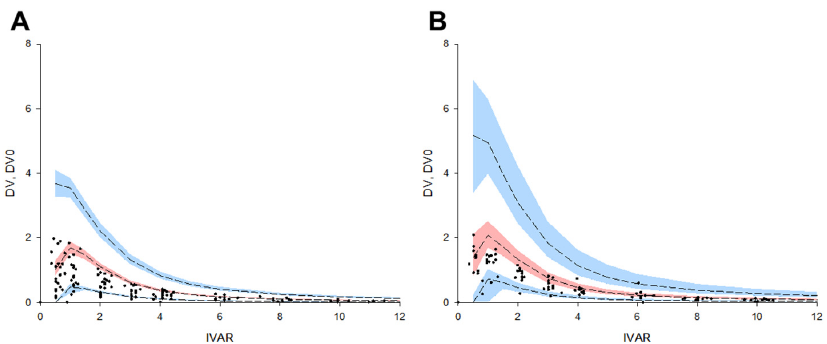
Figure 8. External validation results using the VPC of torsemide’s final Pop-PK model and external data set [8]. Data were stratified with EM ( A ) and IM ( B ) CYP2C9 phenotypes. The dots on the graph represent observations. The black dashed lines mean the 95th, 50th, and 5th percentiles of predicted concentrations, respectively. Blue shaded areas mean 95% CIs for the predicted 95th and 5th percentiles. Red shaded area means 95% CI for the predicted 50th percentile. IVAR ( X -axis) means the time after oral torsemide administration. DV and DV0 ( Y -axis) are observed concentrations of torsemide in the serum and concentrations predicted by the model, respectively.